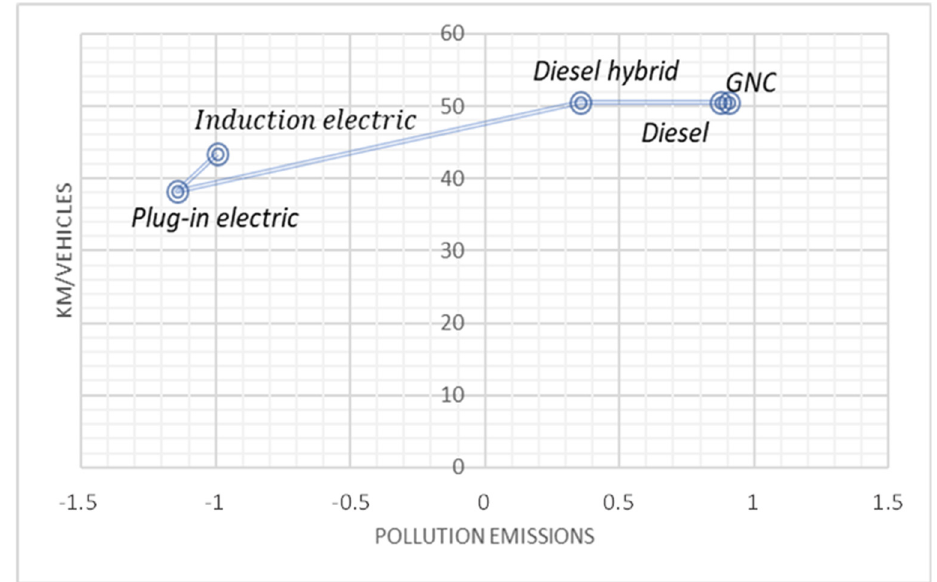
Figure 3. The graphical representation of the results of the DEA